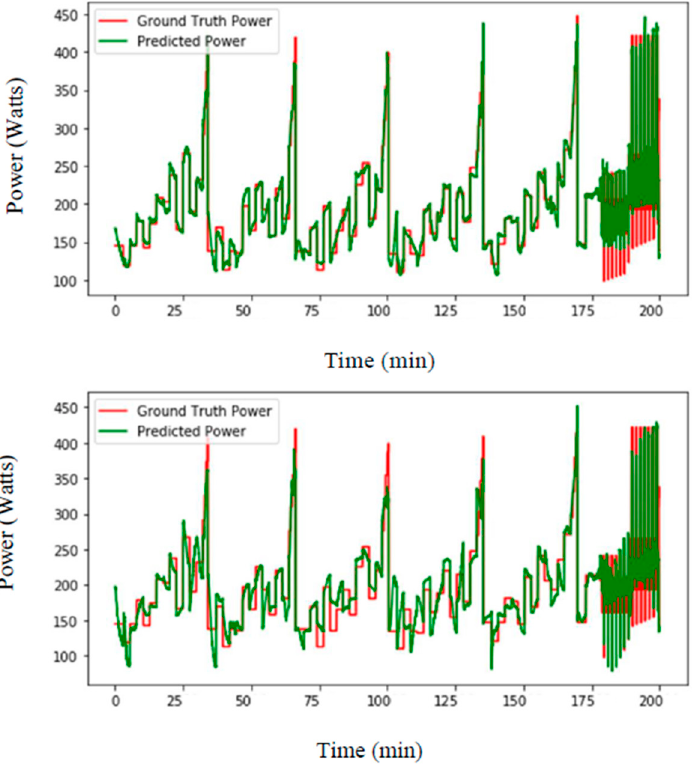
Figure 5. Top: LSTM-based prediction of ski power (watts) for training subjects 1–8 and testing subjects 9–13 where 5% ( top ) and 0.5% ( bottom ) of the data were removed from the testing subject to be used for training.